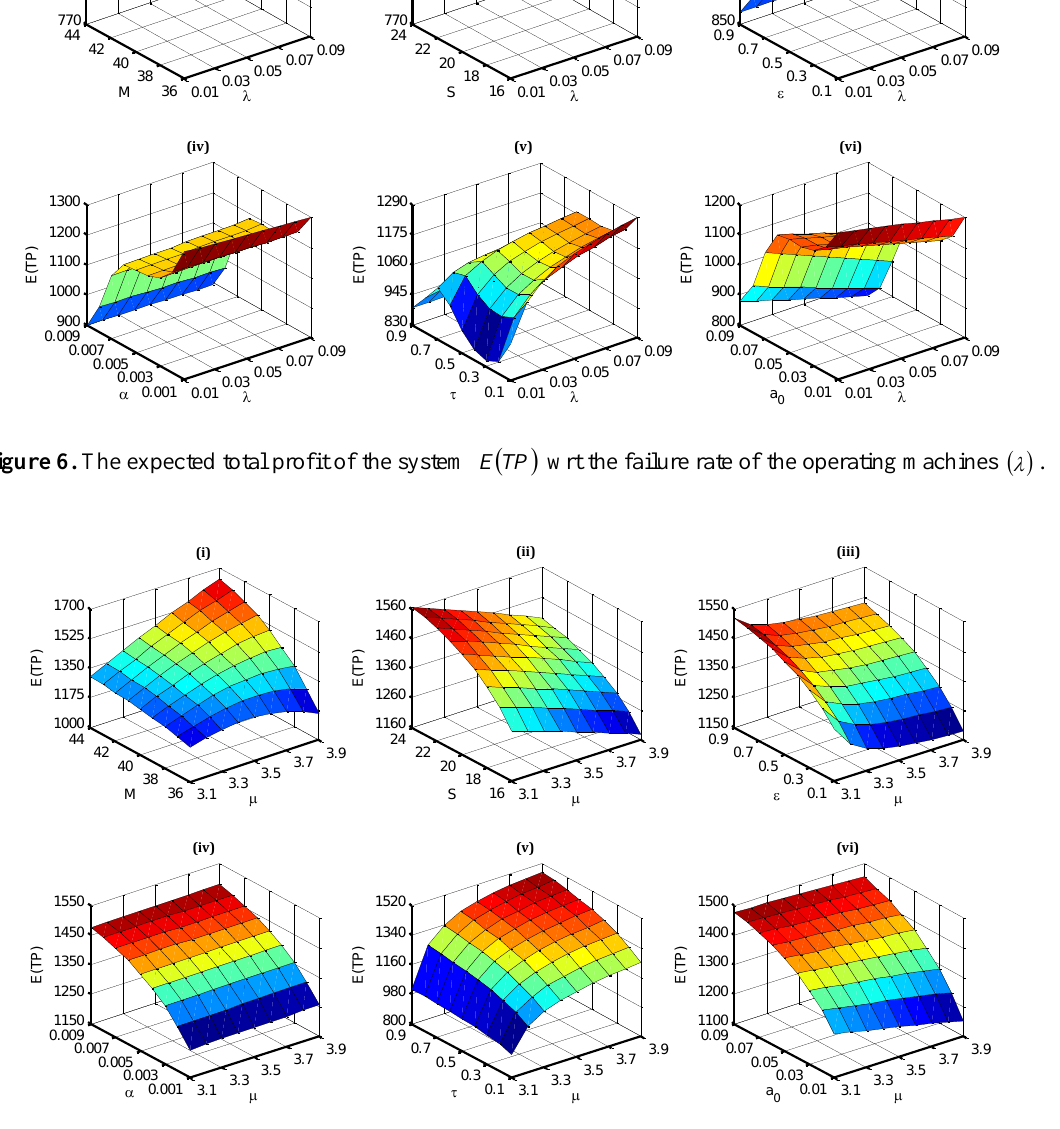
Figure 7. The expected total profit of the system ( ) TPE wrt service rate of the failed machines ( ) 